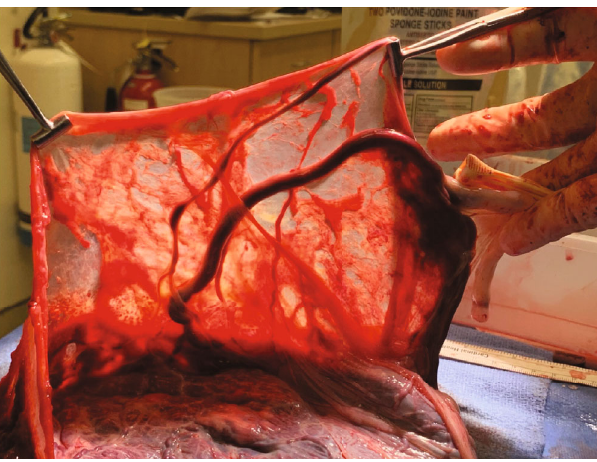
Figure 2: Gross specimen showing vasa previa a ff ecting twin A.